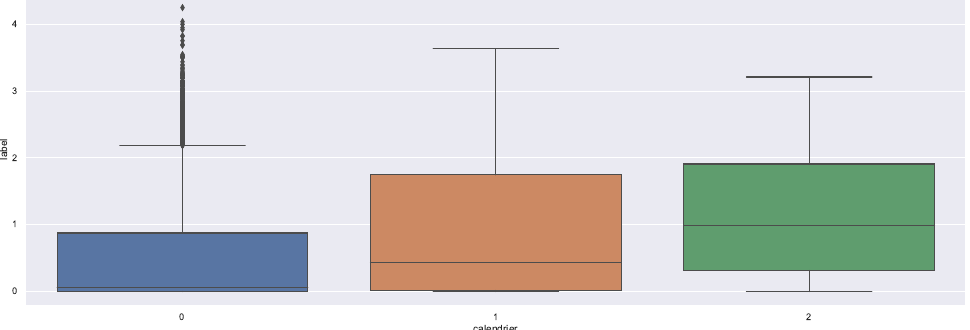
Figure 6. Box-plots of the occupancy as a function of calendar categories.